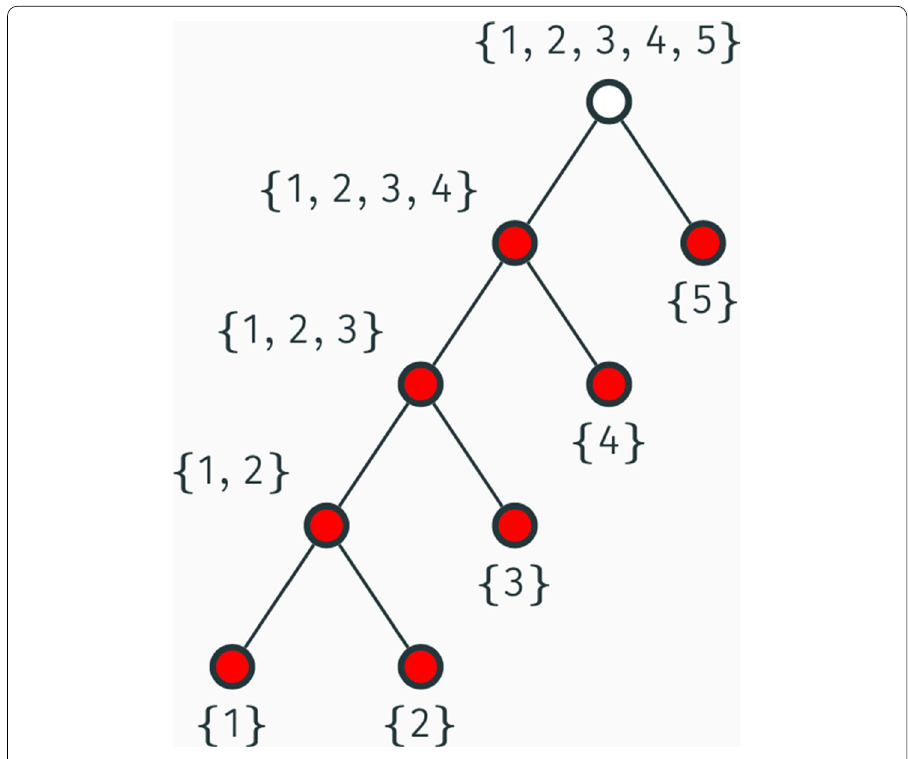
Fig. 1 Example of a linear tree with five variables yielding the tensor train format [21]: T = {{ 1 } , { 1 , 2 } , ... , { 1 , 2 , 3 , 4 }}